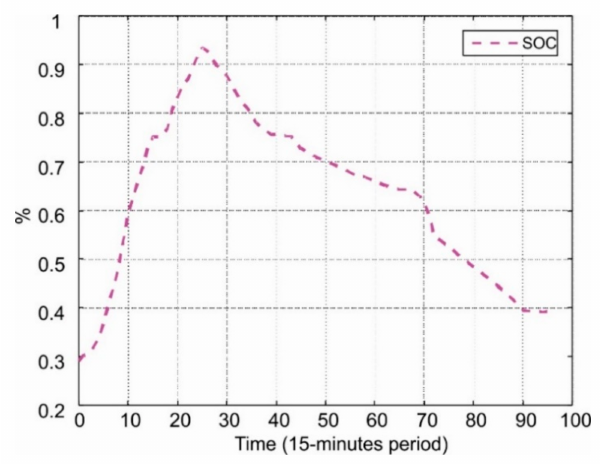
Figure 11. State of Charge